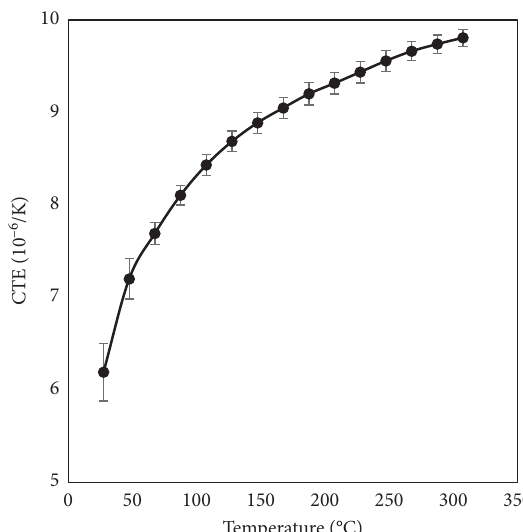
Figure 3: Linear coefficient of thermal expansion of CuCD RHP3434.